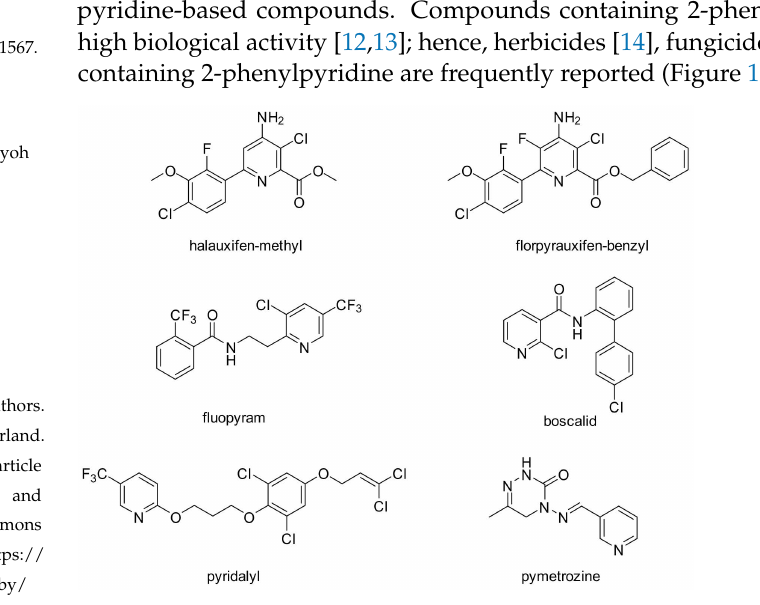
Figure 1. Structures of the reported pyridine-containing